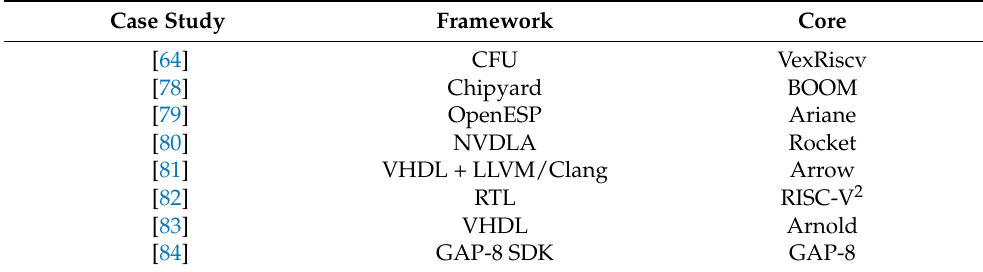
Table 5. Case studies of RISC-V hardware accelerators in machine learning. Case